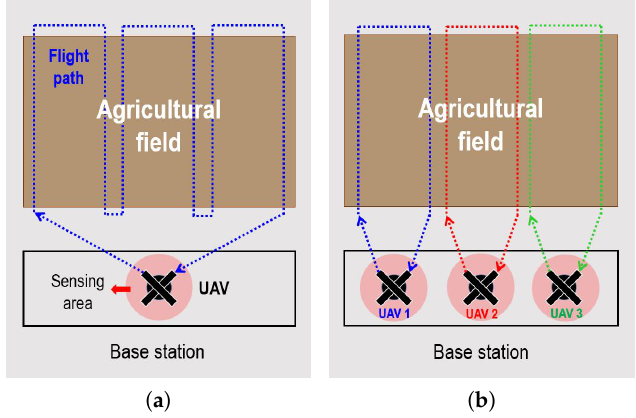
Figure 1. The concept of the remote sensing tasks including sensing area, which the area covered by the camera mounted on the unmanned aerial vehicle (UAV). There is no reference path, and the point where the UAV is located in base station is set as the starting point and the ending point, and the UAV is controlled using the automatic controller and the remote controller according to the operator’s judgment. ( a ) Case of single UAV ( b ) Case of multiple